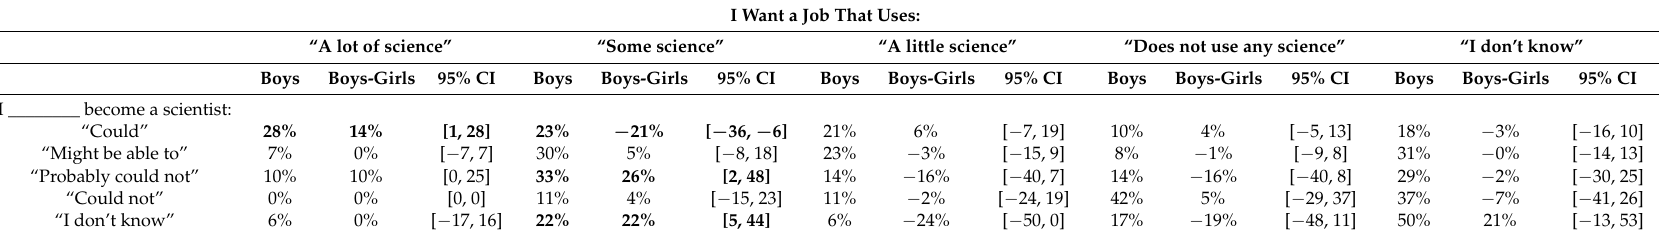
Table 3. Cross-tabulation of self-perceived science potential (“I could”/”might be able to”/”probably could not”/”could not”/“I don’t know if I would” be able to become a scientist) and science career aspirations (I want a job that uses “a lot of science”/”Some science”/”a little science”/”does not use any science”/”I don’t know”) by